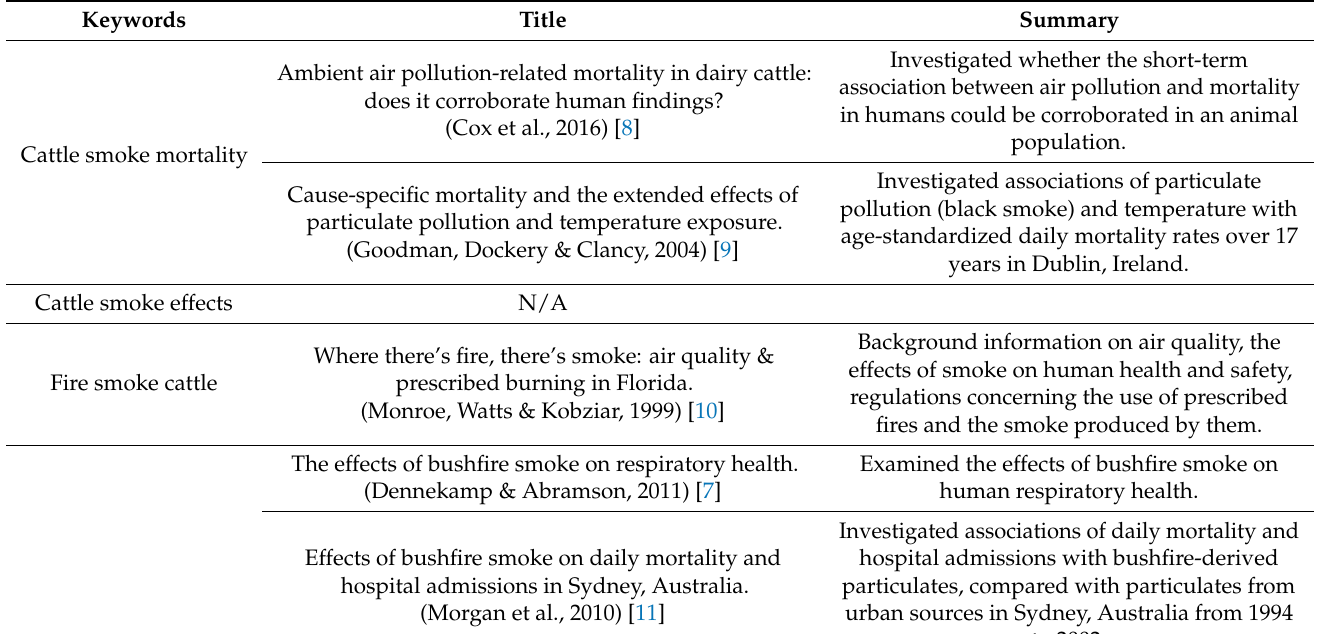
Table 1. Results of a literature search to identify the effect of bushfire smoke on cattle identified by keywords, 1–3 April